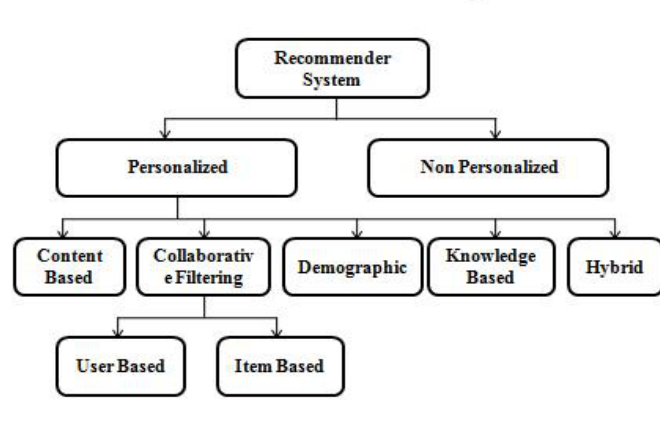
Figure 1. Different types of Recommendation